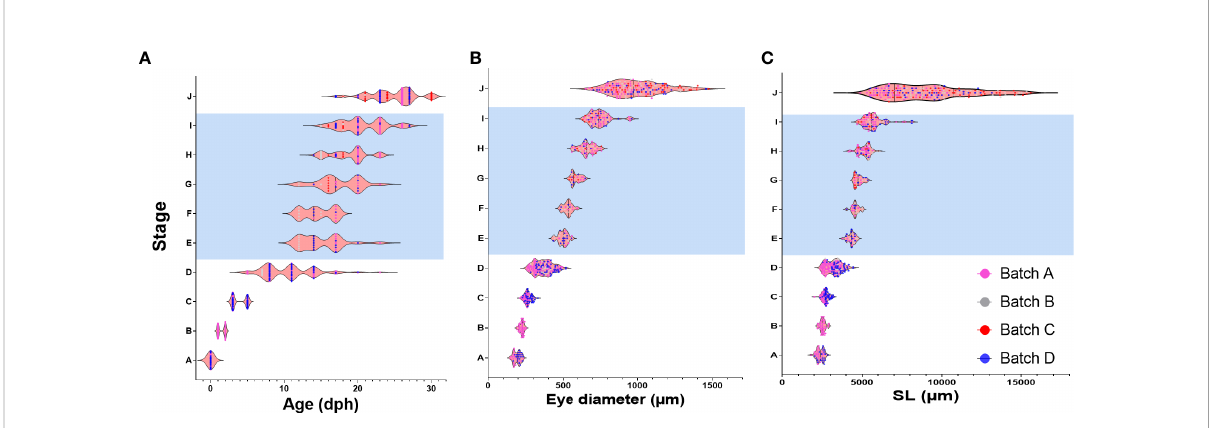
FIGURE 4 Relationship between age, ED and SL and developmental stage. Graphs depict developmental stage as a function of age (A) , eye diameter (B) and standard length (C) . Each dot represents a single larva. Dots are color-coded according to the batch of individual larvae. Shaded area marks the metamorphosis period.